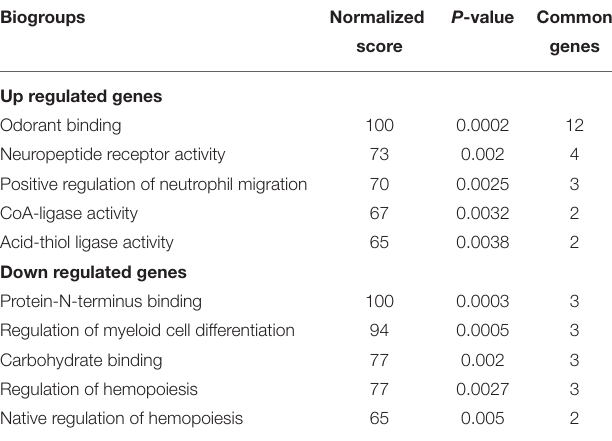
TABLE 2 | Gene ontology pathway enrichment analysis of upregulated and downregulated genes. Biogroups